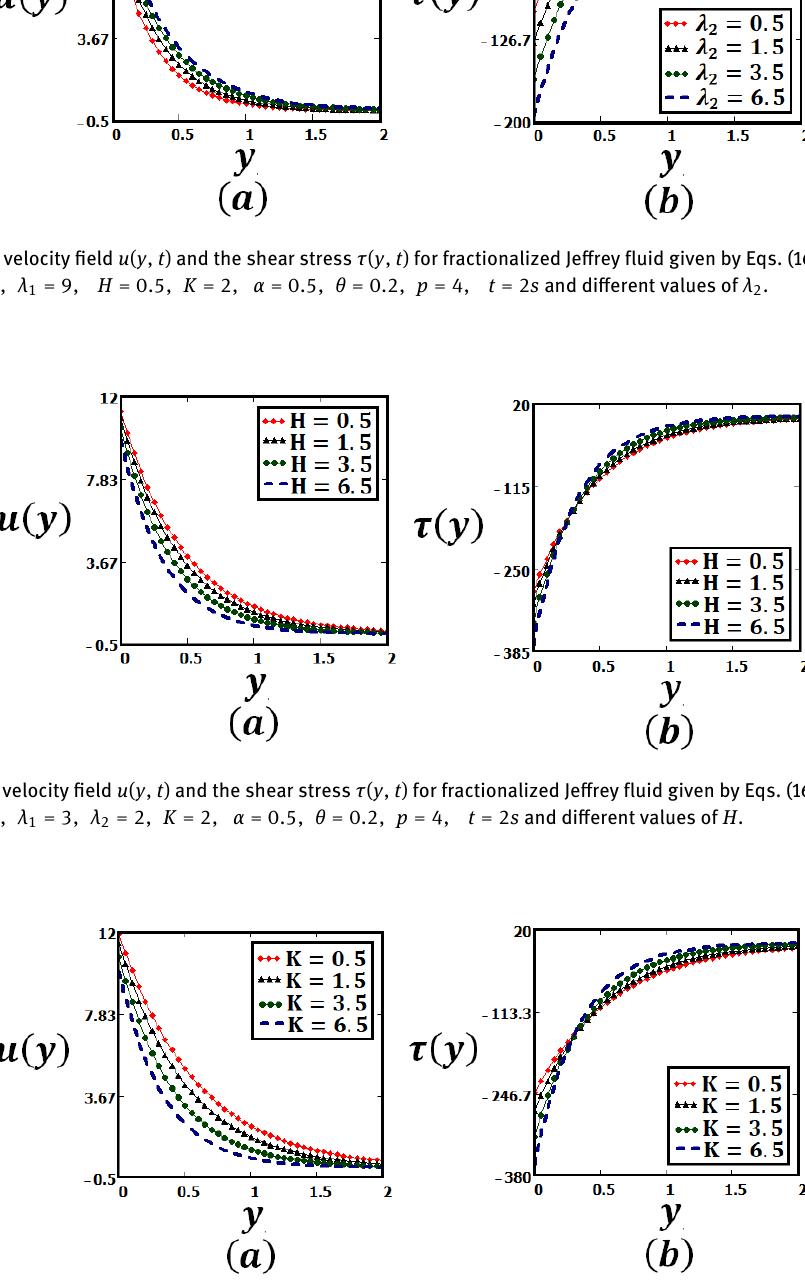
Figure 6: Profiles of the velocity field u ( y , t ) and the shear stress τ ( y , t ) for fractionalized Jeffrey fluid given by Eqs. (16) and (21), for A = 1, ν = 1.427, µ = 19, λ 1 = 3, λ 2 = 2, H = 0.5, α = 0.5, θ = 0.2, p = 4, t = 2 s and different values of K